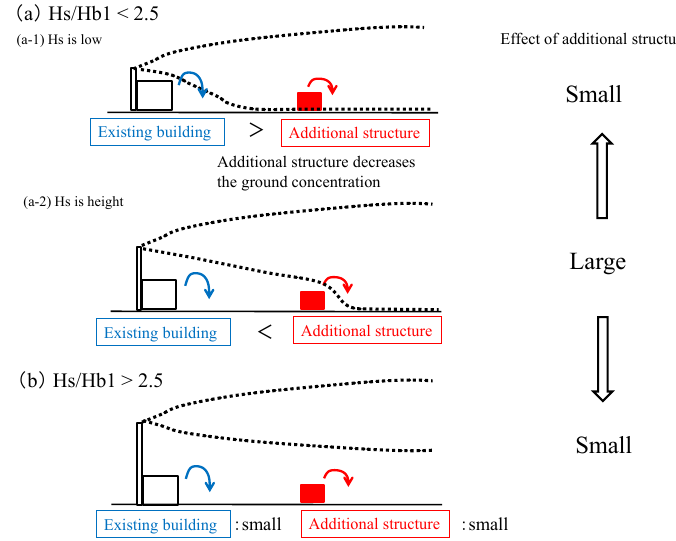
Figure 7. Conceptual diagram of effect of additional structure on gas dispersion. ( a ) Hs/Hb1 < 2.5; ( b ) Hs/Hb1 > 2.5.